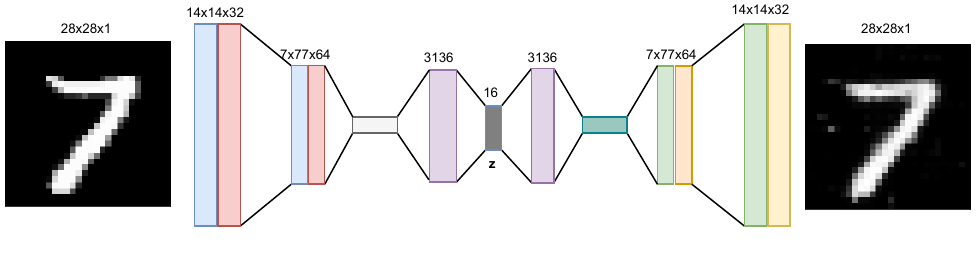
Figure 5. AE used for ensuring data-manifold